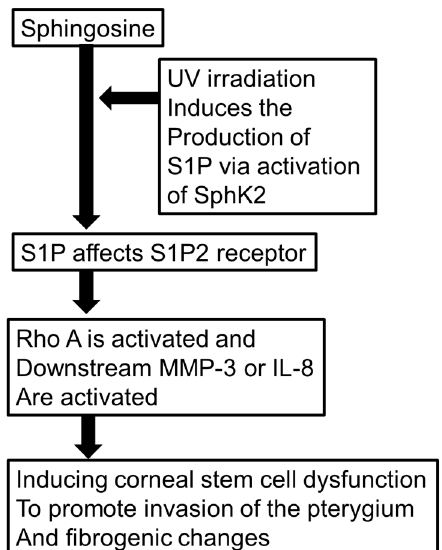
Figure 13. Schematic presentation of signaling cascade / hypothetic SphK2 / S1P2 receptor pathway in the formation of pterygium.